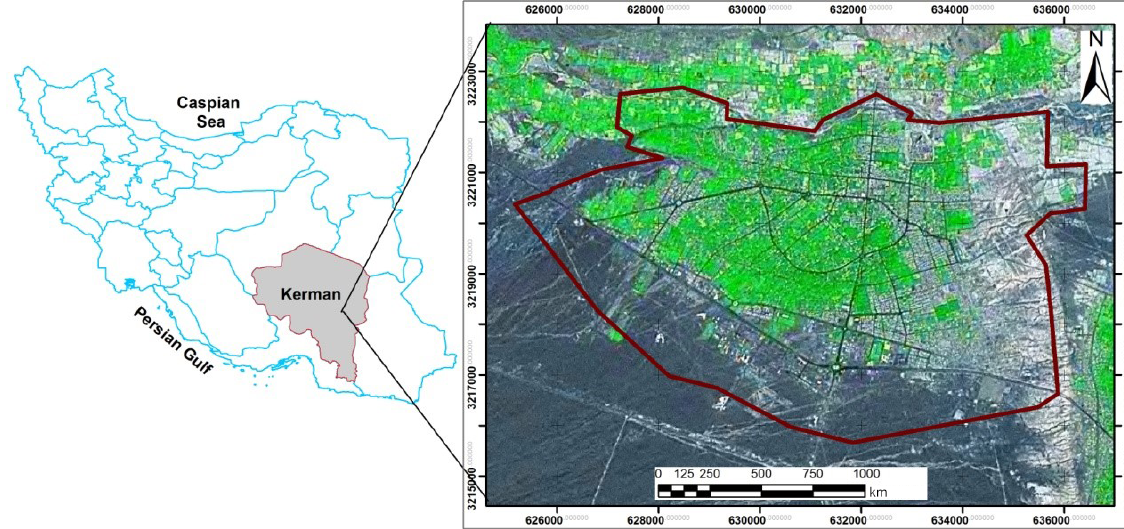
Figure 1. Geographical location of the case study of Bam City, Iran.